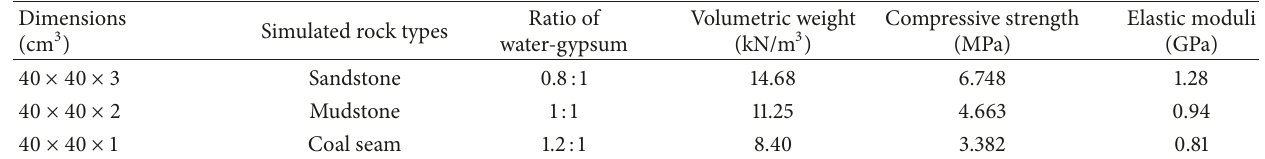
Table 2: Material properties of the elementary